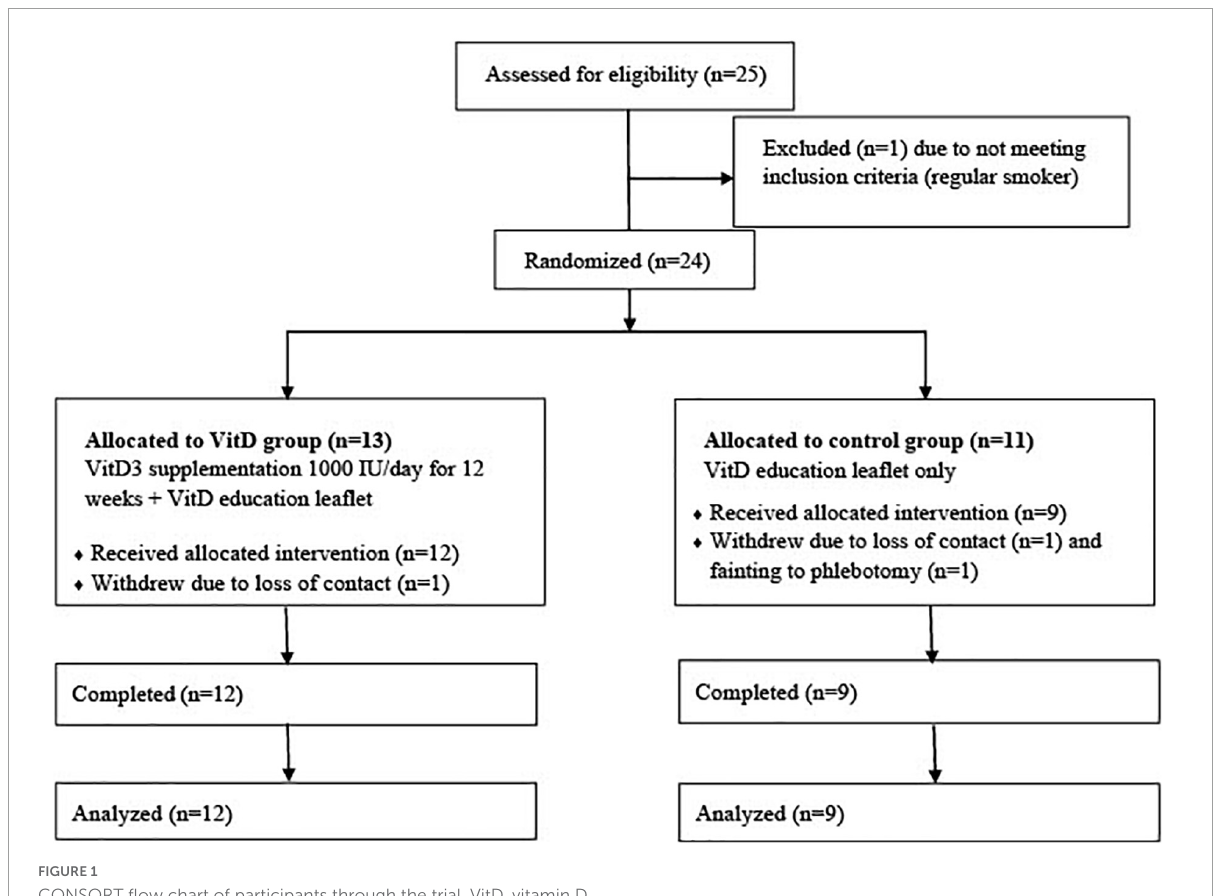
FIGURE1 CONSORT flow chart of participants through the trial. VitD, vitamin D.